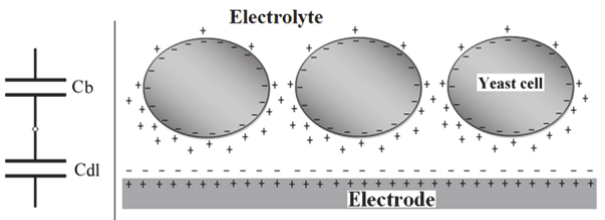
Fig.8: Explanatory model of the decrease in Cdl due to the attachment of